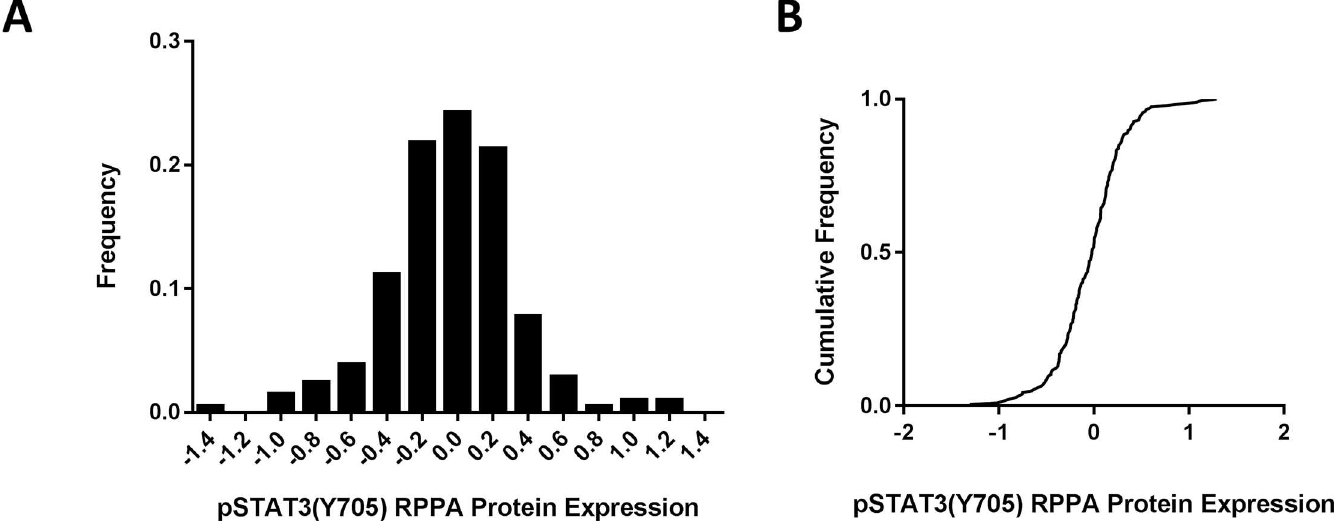
Fig 1. Distribution of pSTAT3(Y705) RPPA scores in HNSCC. The frequency distribution(A) or cumulativefrequency (B) of pSTAT3(Y705) normalized RPPA protein expressionwas plotted for 206 HNSCC tumors. The medianfor these data was -0.01875and the range from -1.306 to 1.2934.